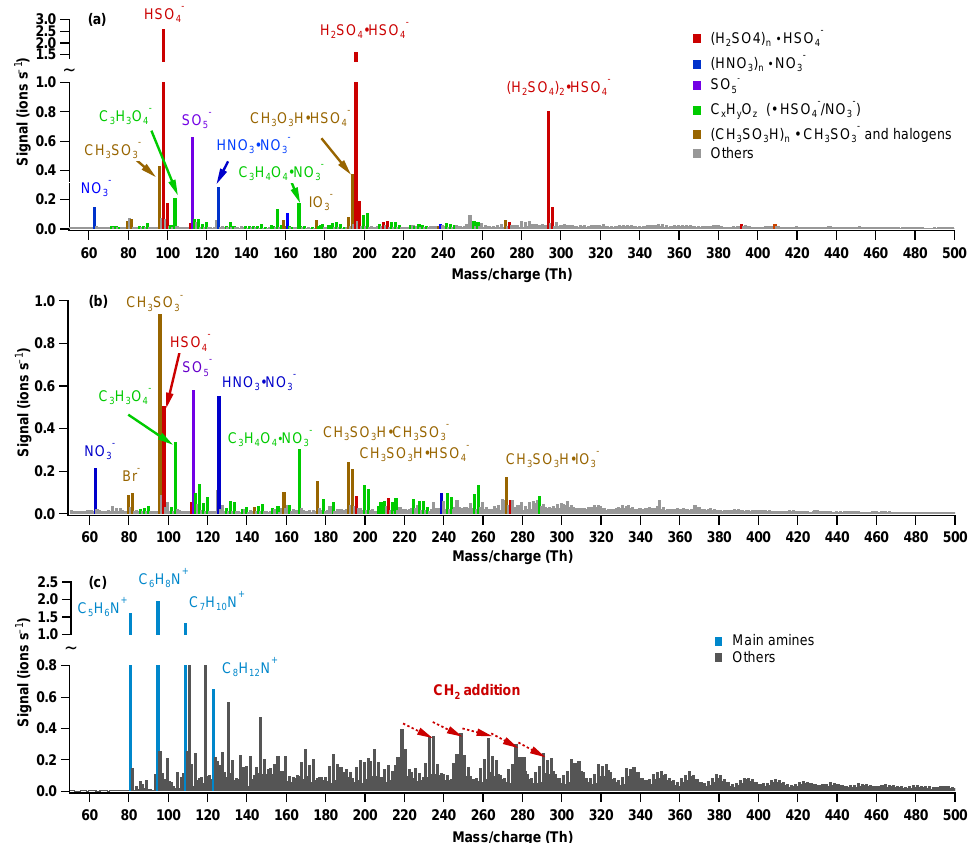
Figure 1. Representative mass spectra of ions from the Jungfraujoch. (a) Average daytime spectrum of negative ions from 53 cloudless days between 10:00 and 14:00LST. (b) Average nighttime spectrum of negative ions from 22 cloudless nights between 22:00 and 02:00LST. (c) Average spectrum of positive ions between 10:00 and 14:00LST on 23 January